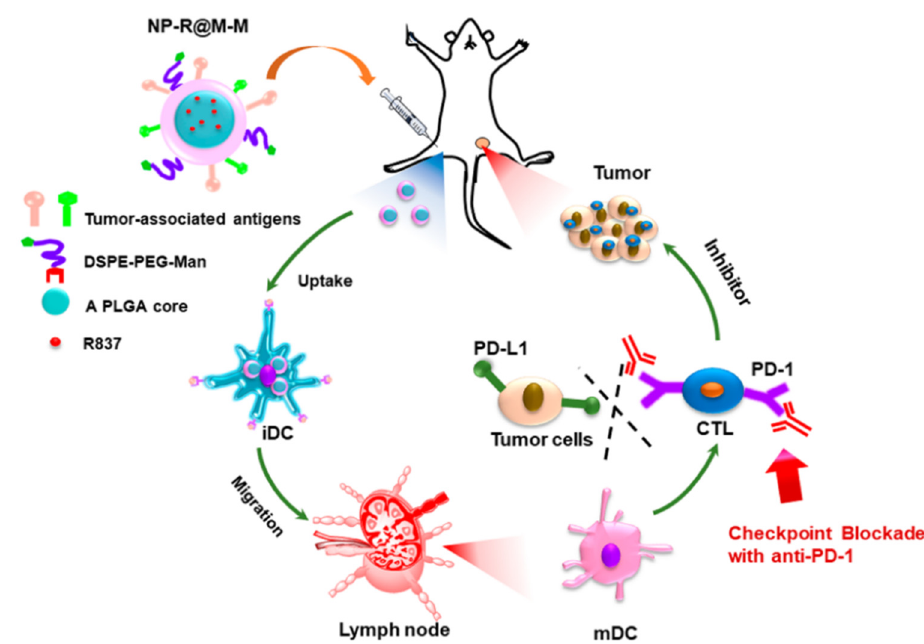
Figure 4. A schematic illustration of the induction of antitumor immune function by the NV based on the melanoma cell membrane as a tumor-specific antigen. Mannose specifically binds to its receptor on dendritic cells (DCs), prompting DC maturation, which works in concert with immune checkpoint inhibition on tumor cells. Reproduced with permission from ref. [78] copyright 2018 American Chemical Society.